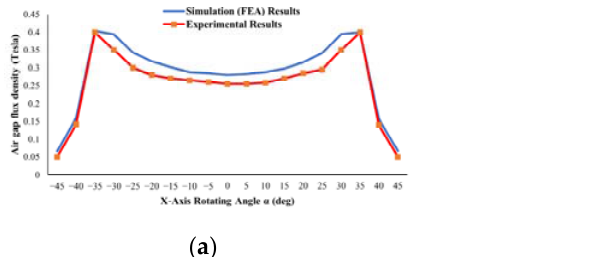
Figure 19. Measured and simulation results of the magnetic flux density in the air gap of the motor rotating around the X ‐ axis from α = 0° to α = ±45° ( a ) and rotating around the Y ‐ axis from β = 0° to β = ±45° ( b ).